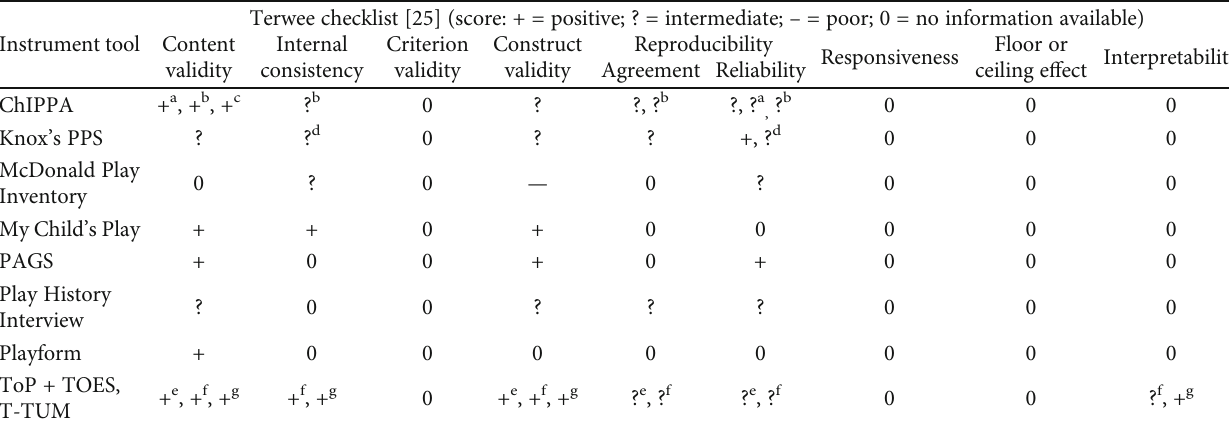
Box 1: Excluded play instruments. Table 3: Summary of the quality of psychometric properties of the